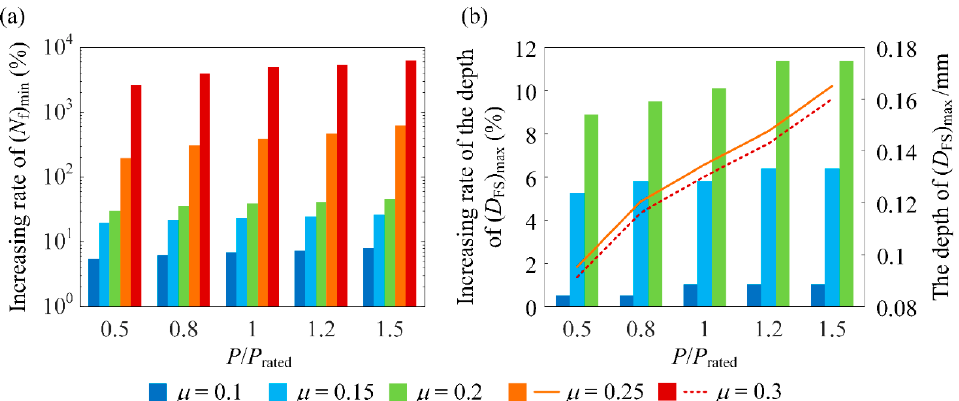
Figure 9. ( a ) The percentage increase in ( N f ) min , and ( b ) the percentage increase in the depth of ( D FS ) max for µ = 0.1, 0.15, and 0.2 (left vertical axis) and the depth of ( D FS ) max for µ = 0.25 and 0.3 (right vertical axis) when the optimum RS distribution is introduced compared to the case without RS.